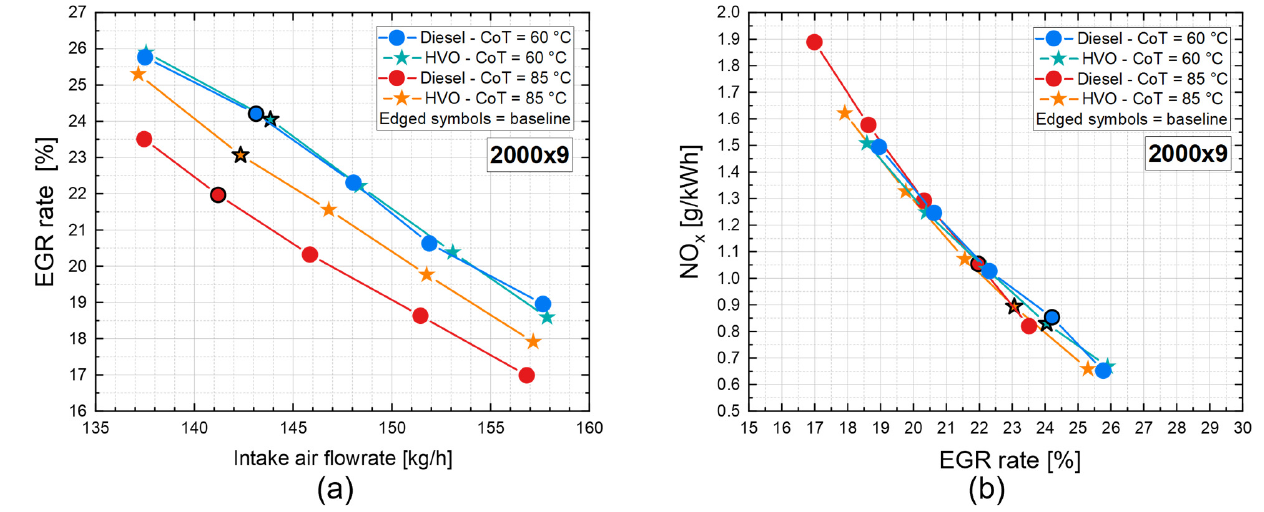
Figure 16. EGR rate as a function of intake air mass flow rate ( a ). The differences between diesel and HVO at high temperature are mainly due to different volumetric efficiency and intake manifold temperature of the engine. NO x /EGR rate trade-off ( b ).